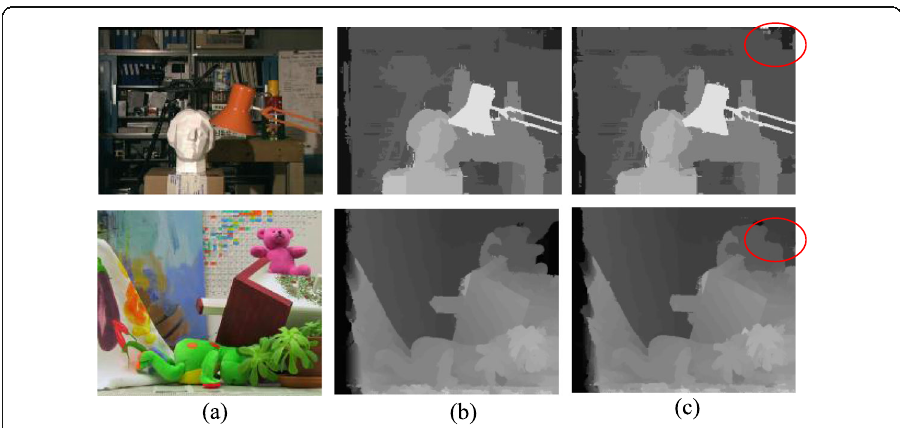
Fig. 7 Disparity maps of Tsukuba and Teddy test images achieved by a left color images, b direct combined cost, and c adaptive cost